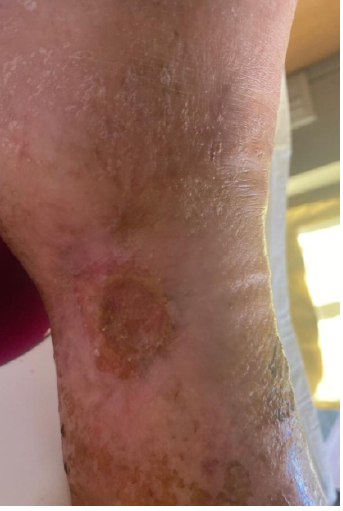
Figure 2. Ulcer at the ninth week of